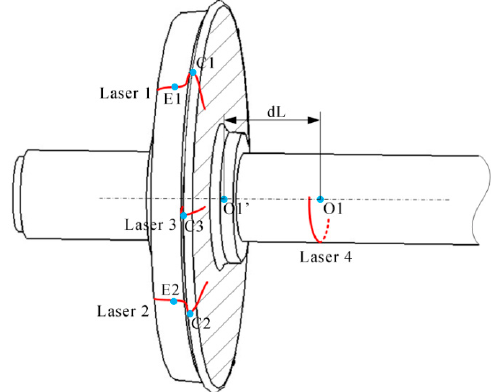
Figure 11. The simulation frame. The diameter of the wheel is set to 840 mm, and dL is the distance from O1 to the wheel rim